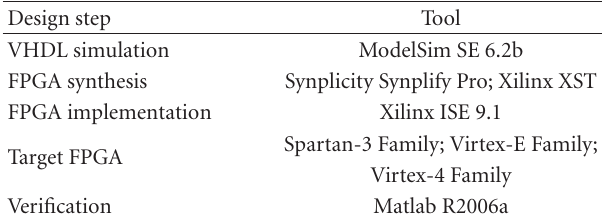
Table 2: Implementation